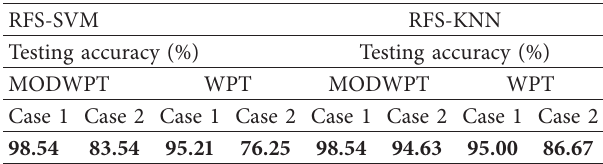
Table 5: Testing accuracies of RFS-SVM and